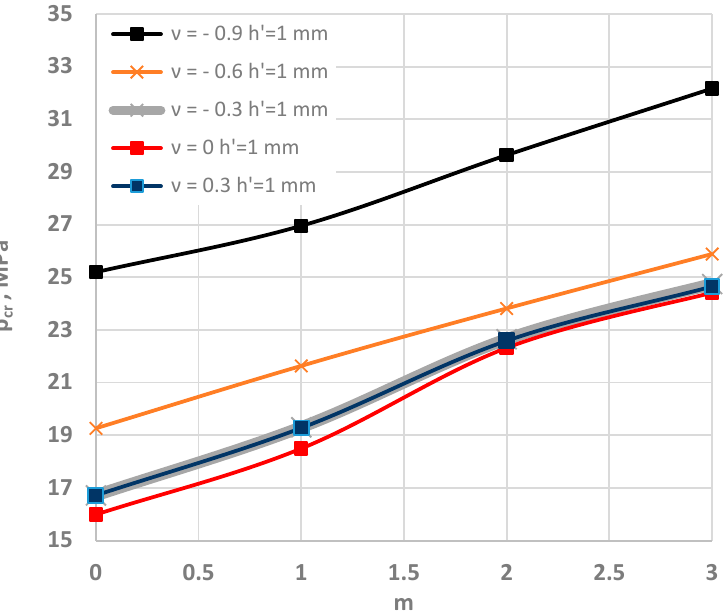
Figure 3. Critical static load p cr distribution versus mode m for plates radially compressed on the inner edge.